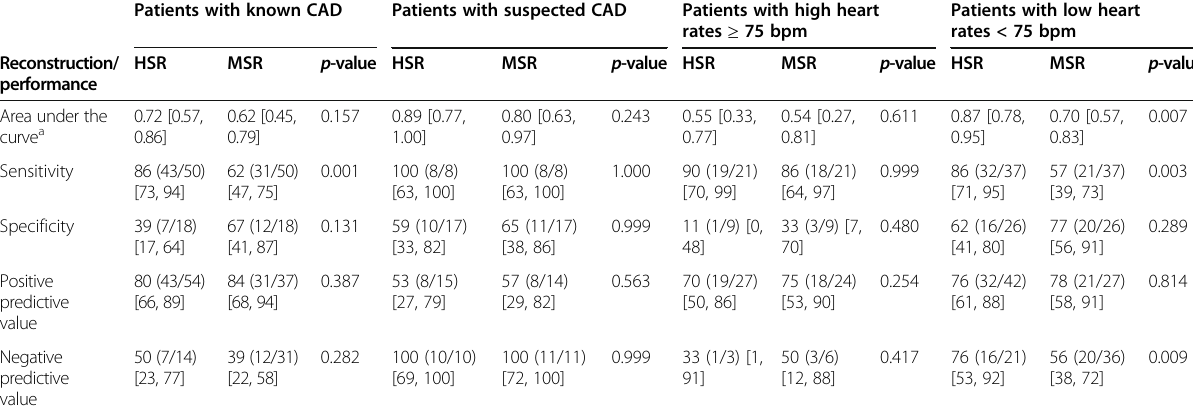
Patients with low heart rates ≥ 75 bpm rates < 75 bpm